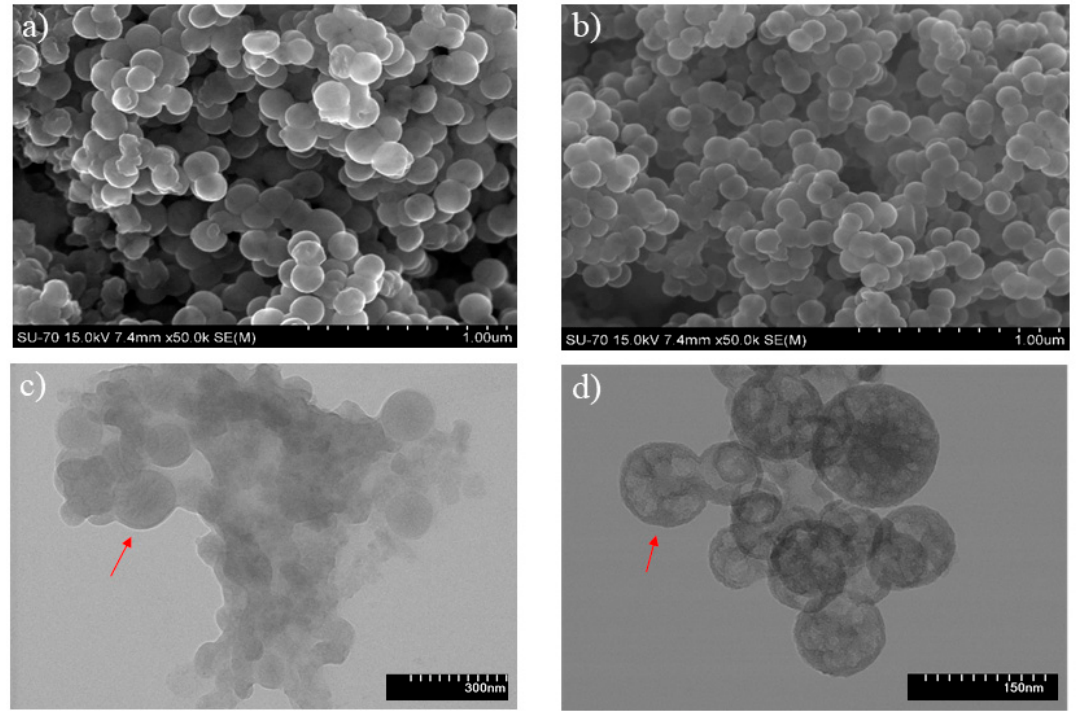
Figure 3. SEM ( a , b ) and scanning transmission electron microscopy (STEM) ( c , d ) images of silica nanocapsules based on N -hexadecyl- N , N , N -trimethylammonium bromide (CTAB) ( a , c ) and QSB2-12 ( c , d ).